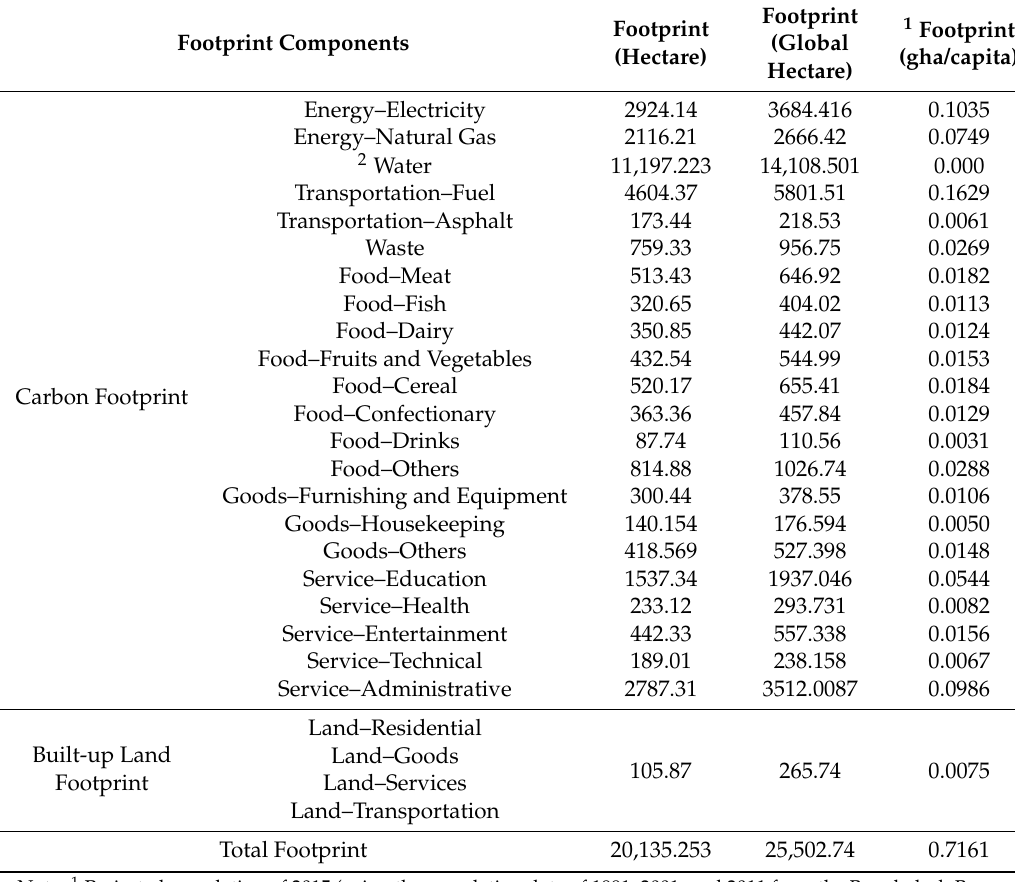
Table 5. Total footprint of ward 24 residential